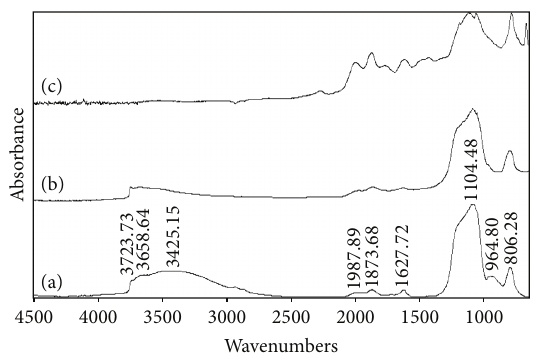
Figure 1: DRIFT spectra of (a) Si, (b) Si